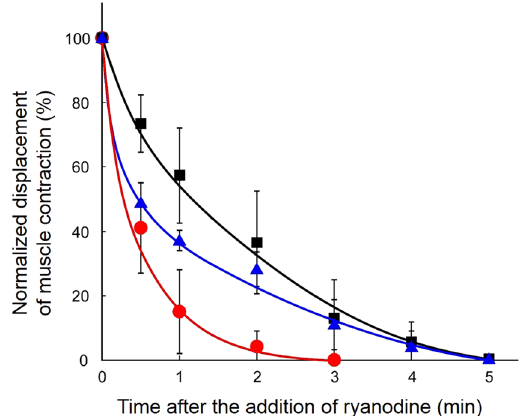
Figure 4. Profiles of muscle contraction suppressed by the addition of ryanodine (black square: 50, blue triangle: 100, and red circle: 200 μ M). The displacement was normalized to that just after the addition of ryanodine (time = 0 min) as 100% and indicates the rate of decrease (n = 4). EPS (frequency: 1 Hz) was continuously applied in these